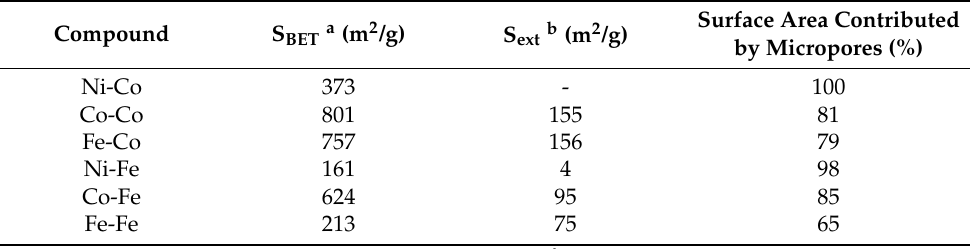
Table 6. Comparison of total surface area (S BET ), external surface (S ext ) area, and micropore surface area of hexacyanometallates(III) based on N 2 adsorption data.